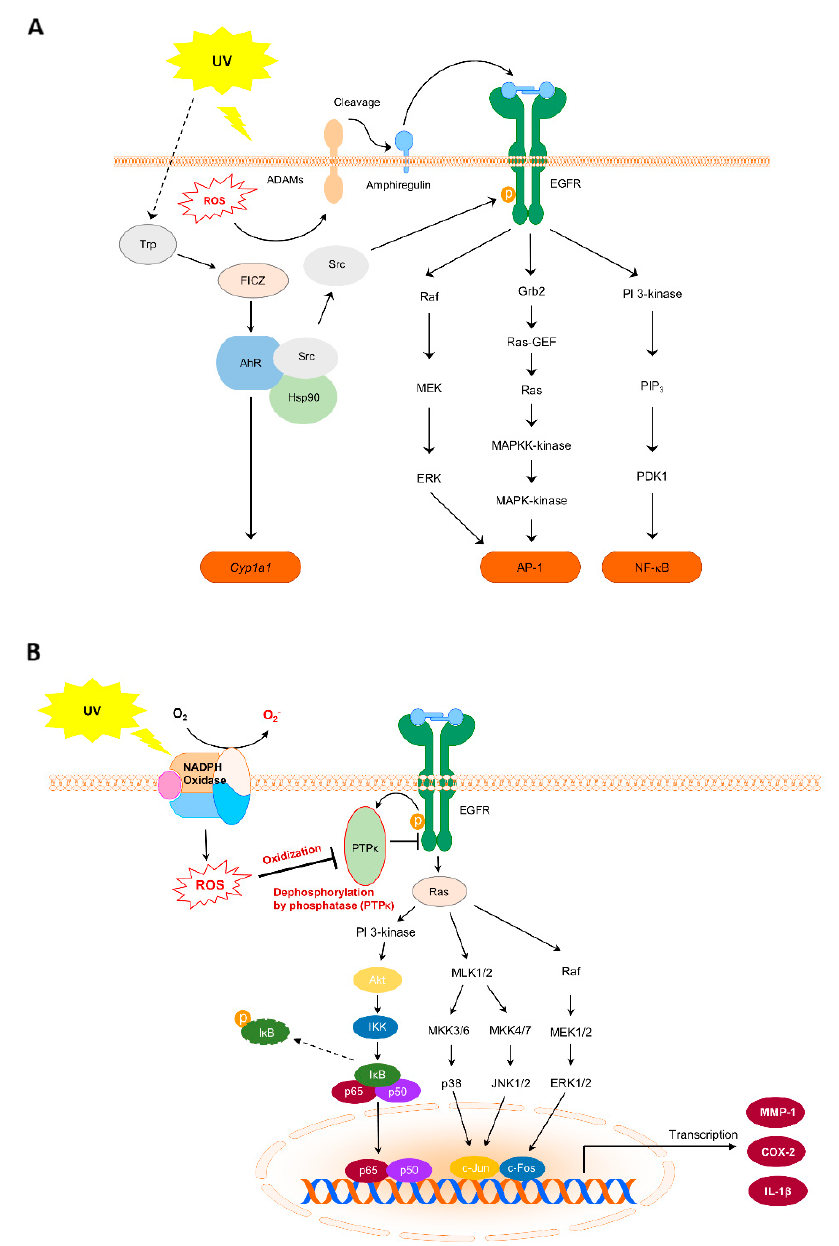
Figure 2. Epidermal growth factor receptor (EGFR) and its downstream signaling pathways, and the possible mechanisms of UV radiation-induced skin carcinogenesis. ( A ) EGFR and its downstream signaling pathways in UV-induced skin carcinogenesis. ( B ) NOX and PTP κ signaling pathways in UV-induced skin carcinogenesis.